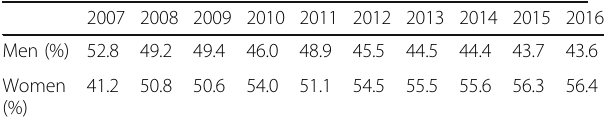
Table 5 Gender distribution of sudden death